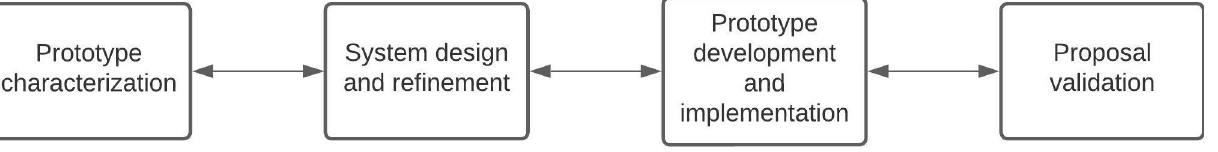
Figure 1. General activities followed for the design and implementation of the prototype rehabilitator for upper torso areas.